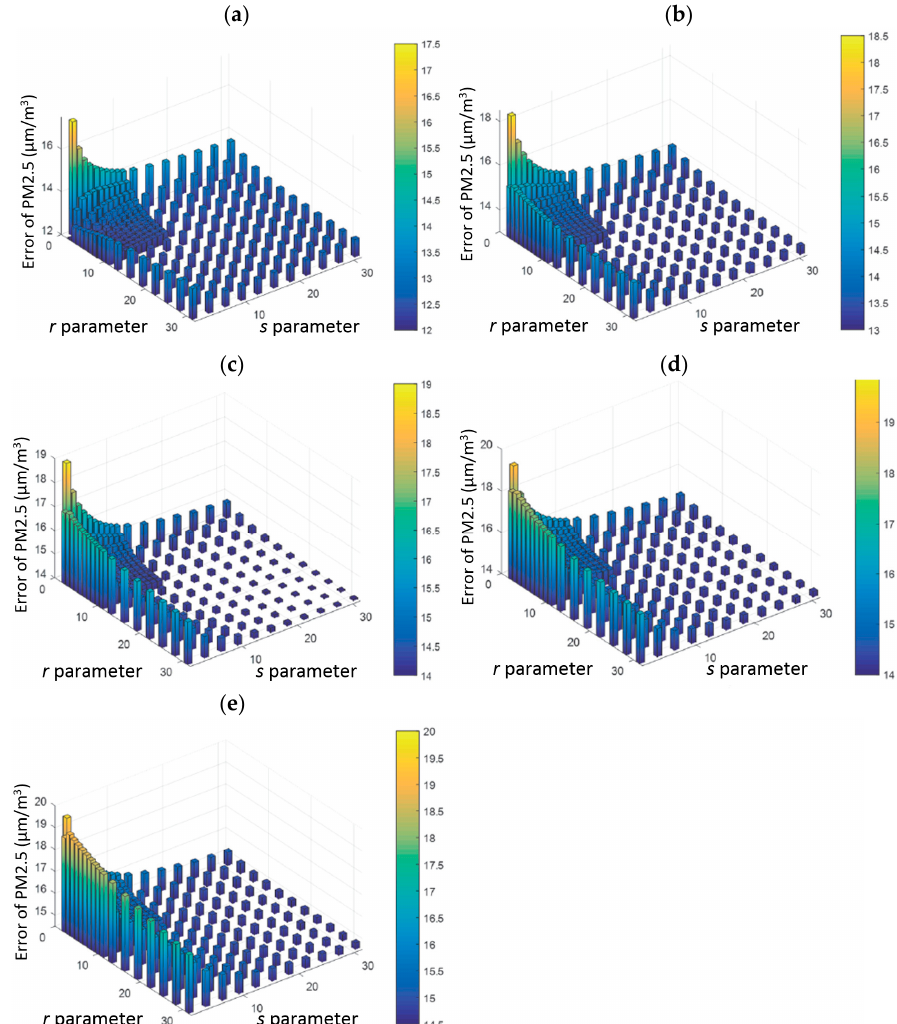
Figure 11. PM2.5 RSME of various r and s at the ( a ) 6th, ( b ) 12th, ( c ) 24th, ( d ) 36th, and ( e ) 48th hours.